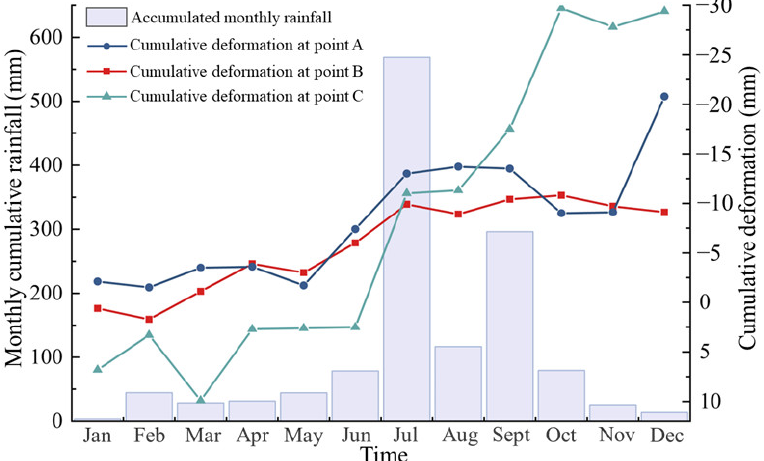
Figure 23. Response relationship between InSAR time series deformation and rainfall (the positions of points A, B and C are shown in Figure 17).